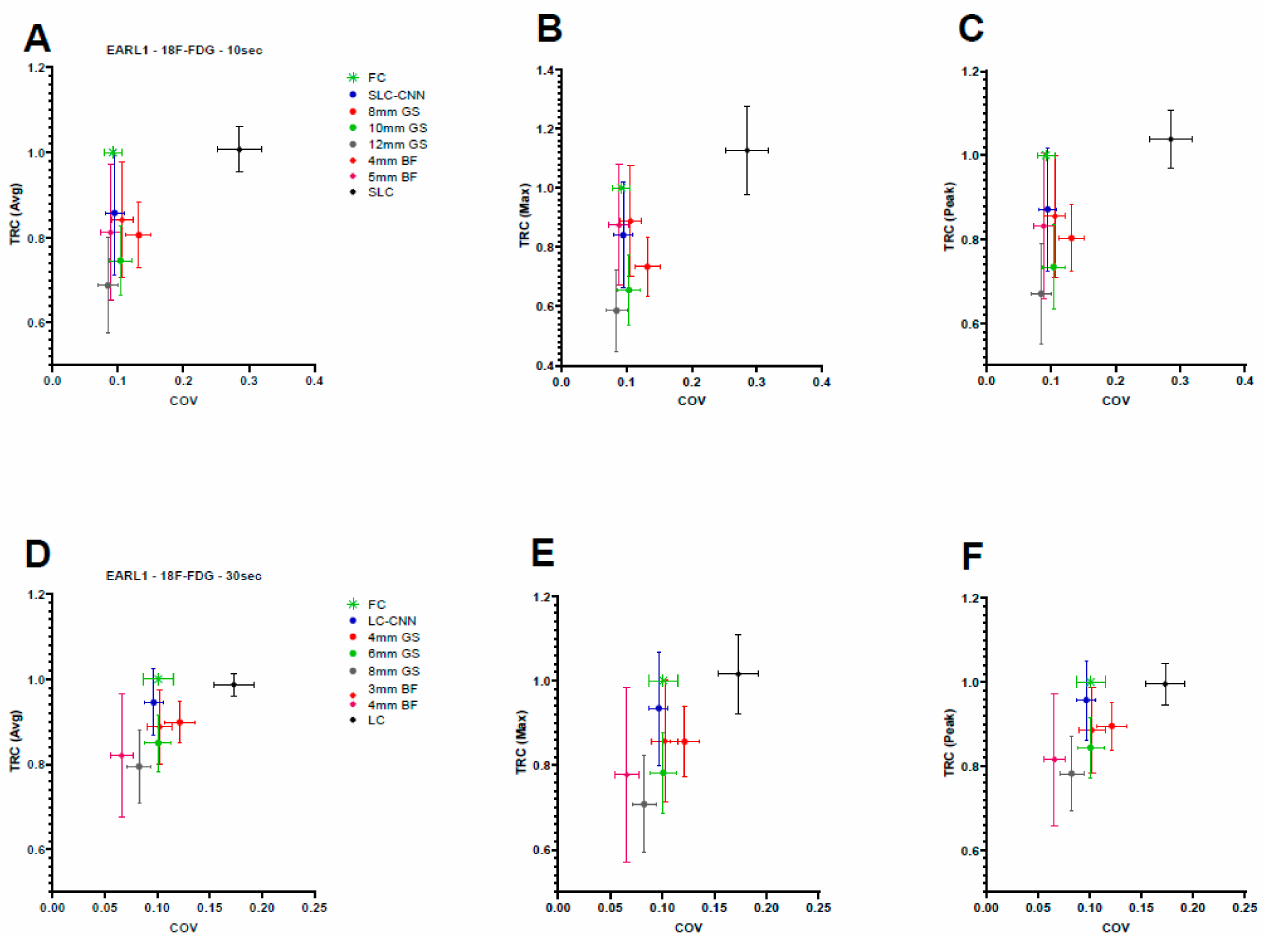
Figure 2. The performance of the denoising methods for low-count 18 F-FDG PET. The ( A ) average, ( B ) maximum, ( C ) 3Dpeak TRC of the SLC-CNN, GS (8 mm, 10 mm and 12 mm) and BF (4 mm and 5 mm) denoising methods of the SLC 18 F-FDG PET from the Ingenuity TF PET/CT and the Vereos Digital PET/CT scanner. The ( D ) average, ( E ) maximum, ( F ) 3Dpeak TRC of the LC-CNN, GS (4 mm, 6 mm and 8 mm) and BF (3 mm and 4 mm) denoising methods of the LC 18 F-FDG PET from the Ingenuity TF PET/CT and the Vereos Digital PET/CT